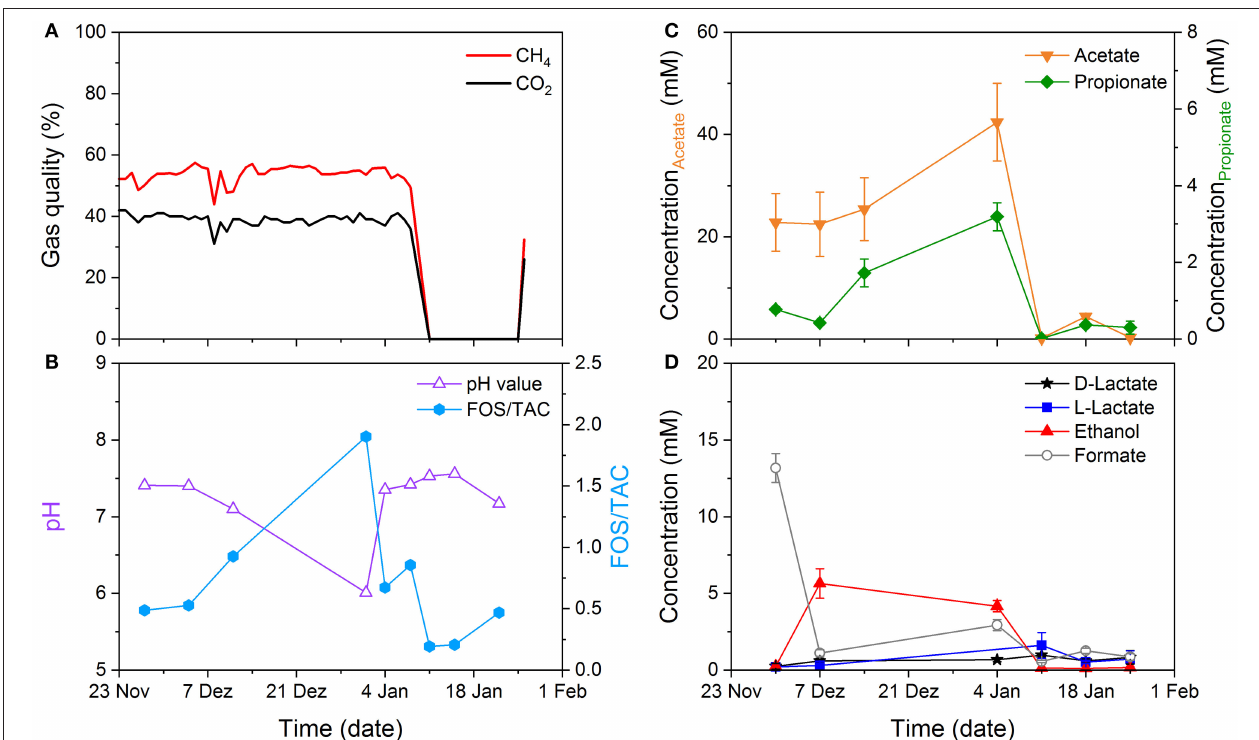
FIGURE 6 | Reactor performance of a lab-scale biogas reactor. (A) Online monitoring of gas quality (CH 4 and CO 2 ). (B) pH and FOS/TAC were analyzed offline. Concentration of (C) volatile fatty acids (acetate and propionate), and (D) organic acids (ethanol, formate, D - and L -lactate) measured with the VFA and OA biosensor,